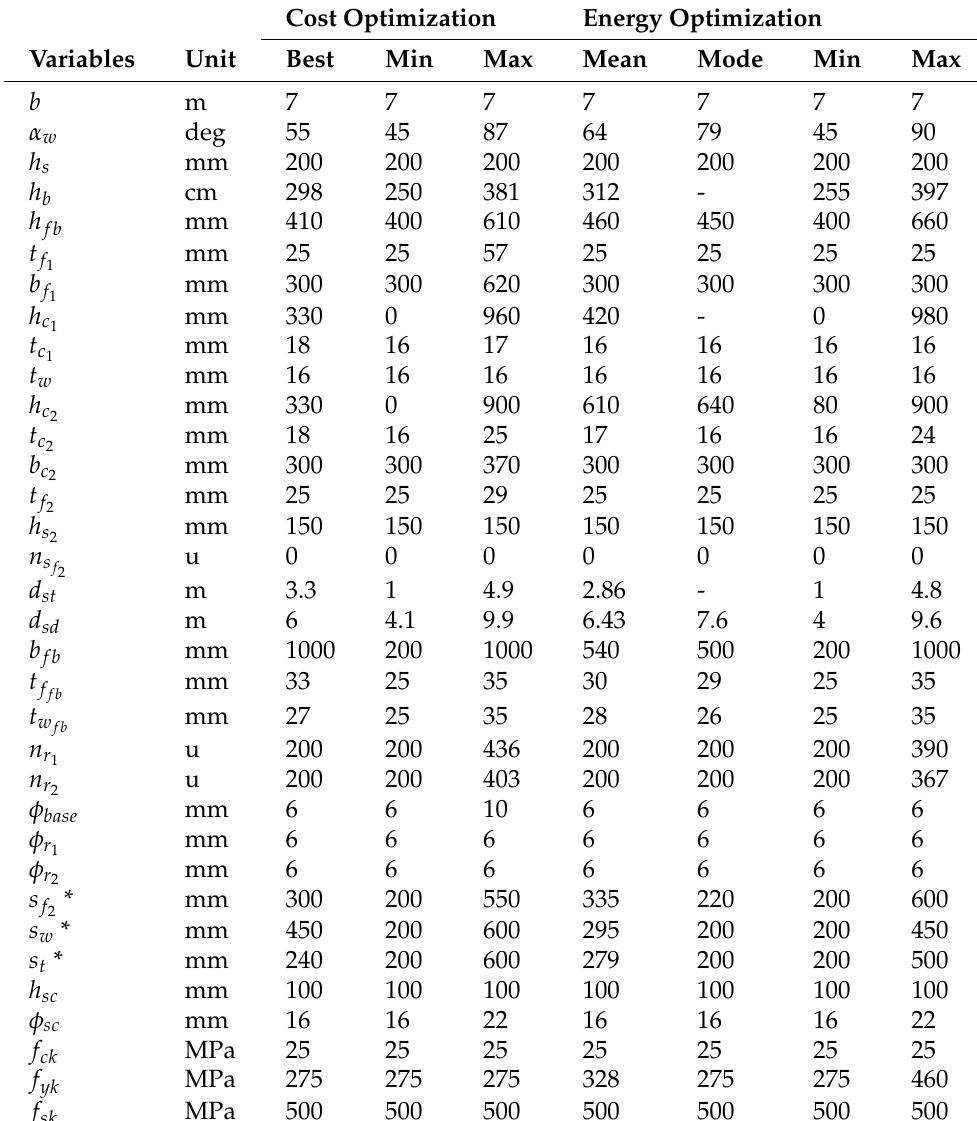
Table 10. Design variables minimum and maximum values for best cost and energy optimization